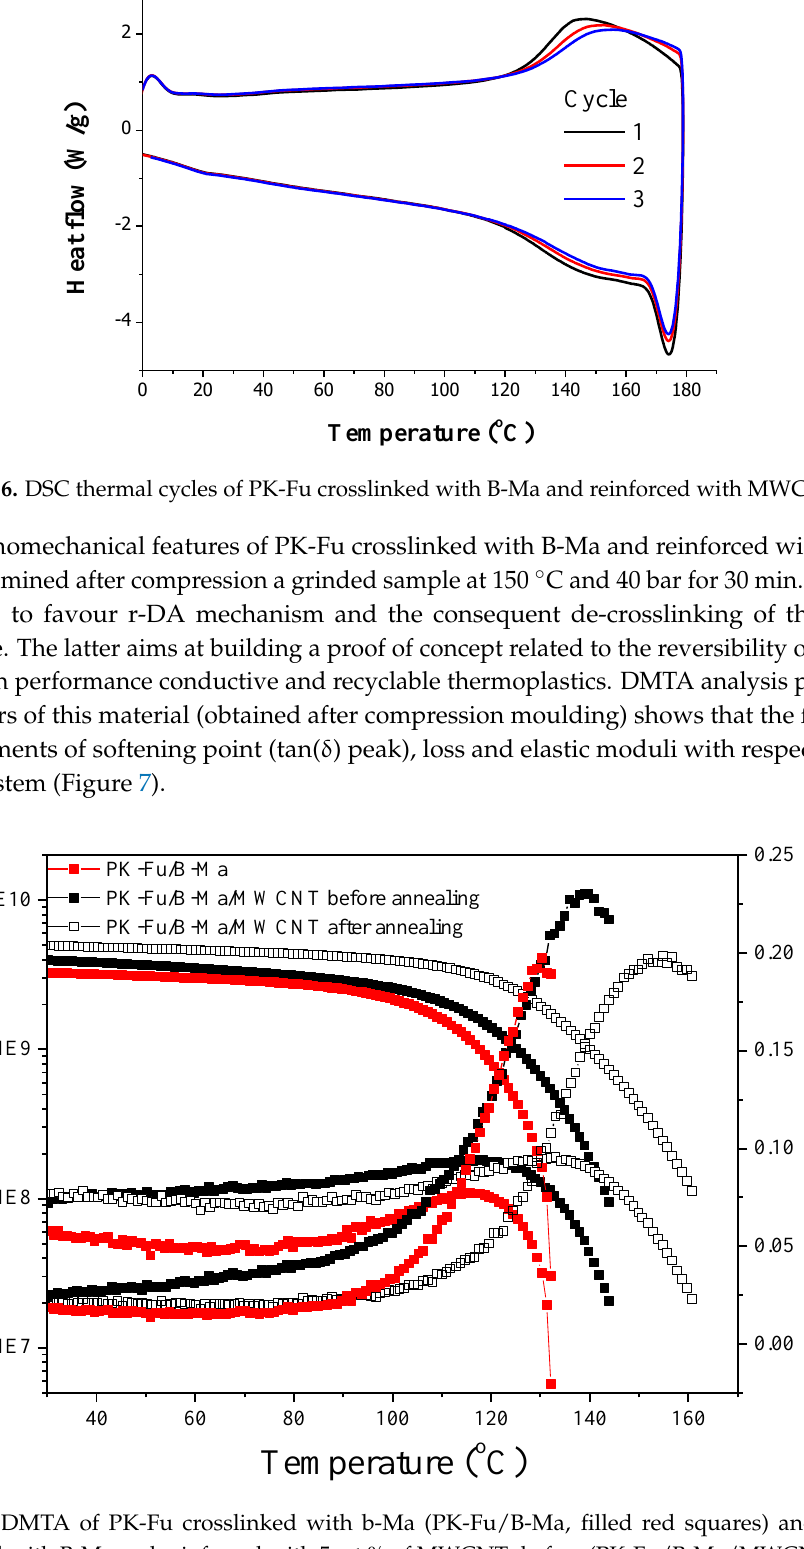
Figure 7. DMTA of PK-Fu crosslinked with b-Ma (PK-Fu/B-Ma, filled red squares) and PK-Fu crosslinked with B-Ma and reinforced with 5 wt.% of MWCNTs before (PK-Fu/B-Ma/MWCNT, filled black squares) and after resistive heating annealing (PK-Fu/B-Ma/MWCNT, black empty squares) for 24 h using 35 V.